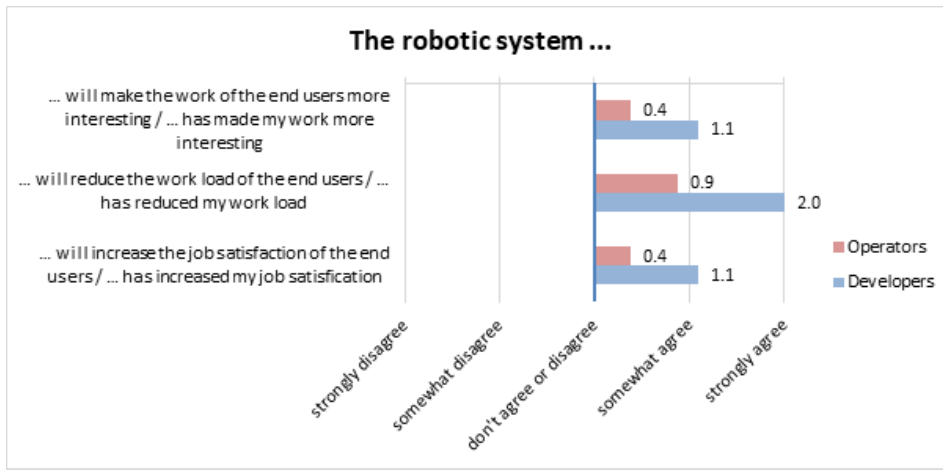
Figure 8. Overview of the perceived impact of the robotic cell on the working conditions. (Average of the answers within a 5-point scale, from −2 strongly and −1 somewhat disagree over 0 do not agree or disagree to +1 somewhat agree to +2 strongly agree).